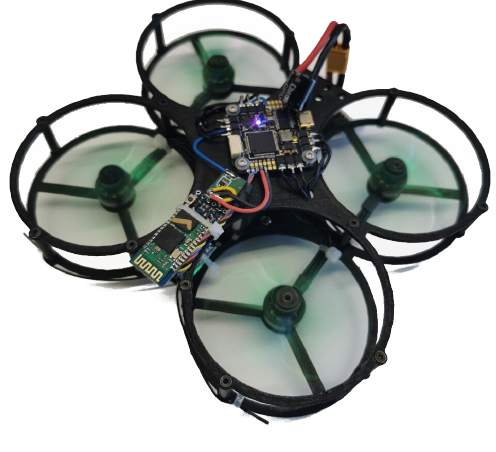
Figure 3. Picture of the drone considered in this